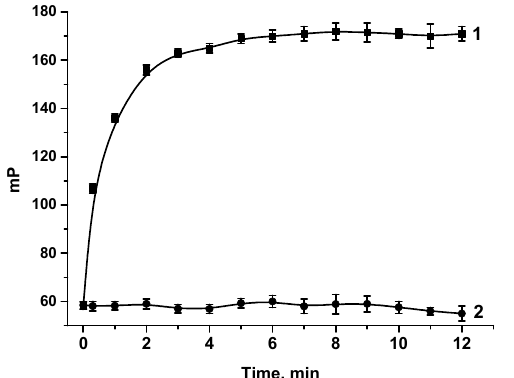
Figure 5. Kinetics of the tracer interaction with speci fi c (1) and nonspeci fi c (2) MAbs.